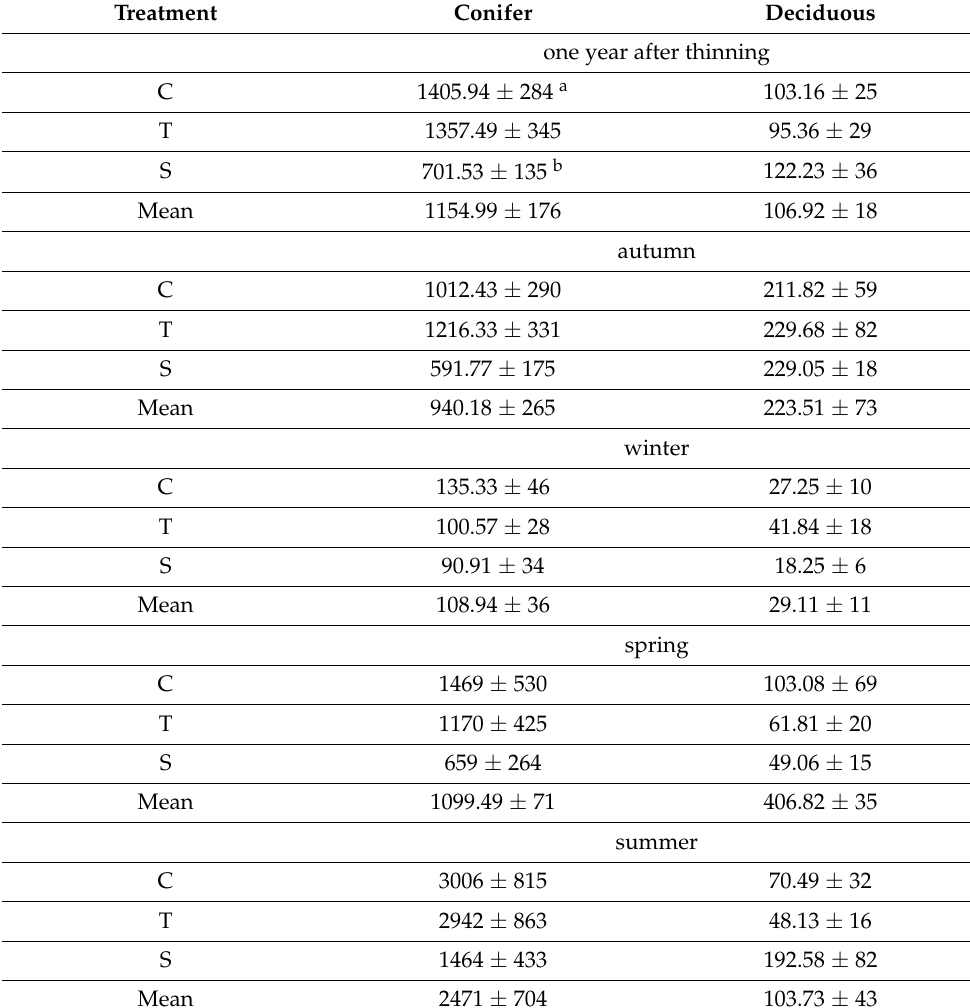
Table 4. Mean cumulative litterfall production for conifers and deciduous trees (mean ± SD) ex- pressed as kg · ha − 1 of three replicates for three thinning treatments during four seasons in the study period (16 October until 17 September). (C: Control, T: Traditional. S: Selective). Treatment Conifer